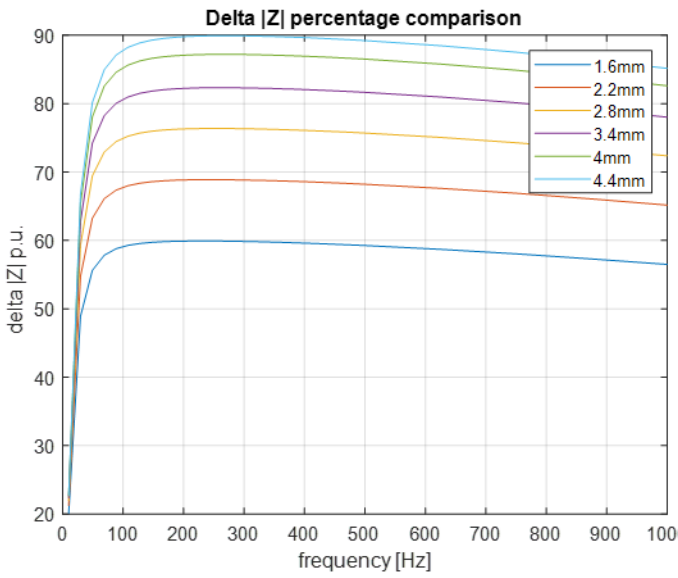
Figure 13. Trapezoidal slot—impedance comparison.